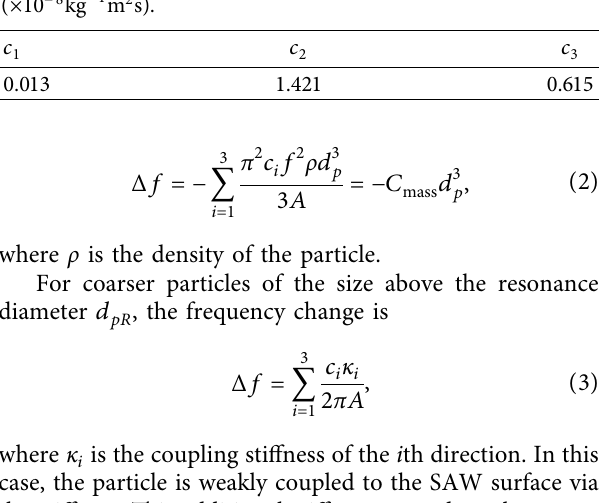
Table 1: Coupling coefficients for Rayleigh-type